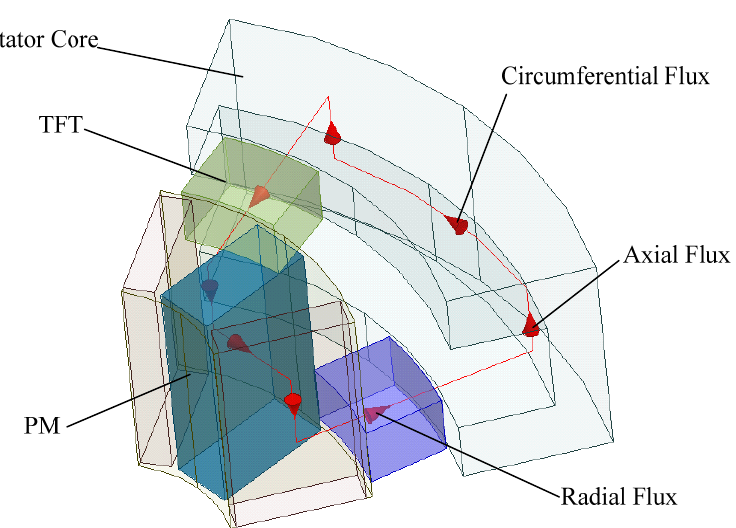
Figure 5. Magnetic flux path for a two-pole